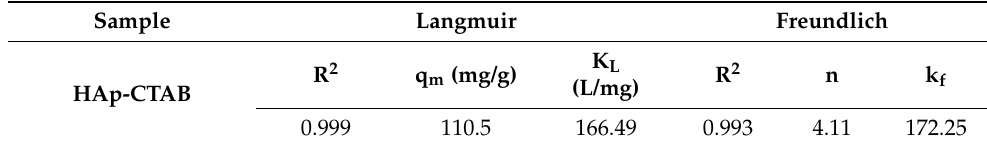
Table 1. Langmuir and Freundlich isotherm parameters for Pb 2+ adsorption onto HAp- CTAB